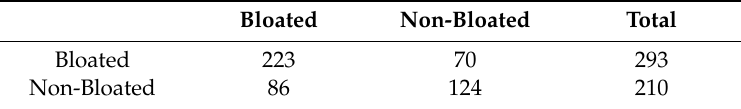
Table 5. Confusion matrix of the test set of the MLFN model used in predicting the classification bloated versus non-bloated activity statuses. Targets are reported on rows. The correctly classified samples are reported on the main diagonal of the